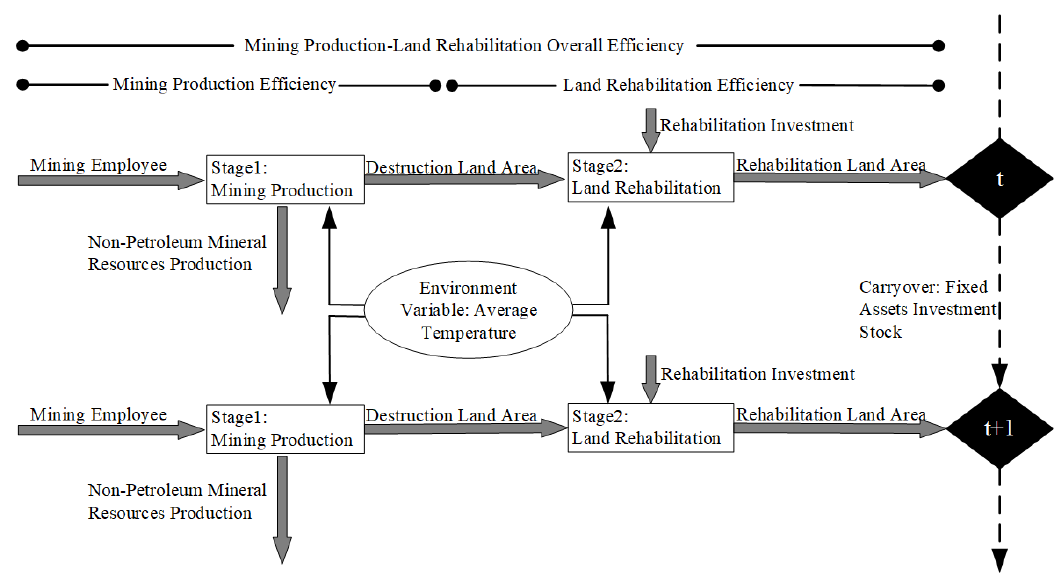
Figure 1. Network dynamic model.